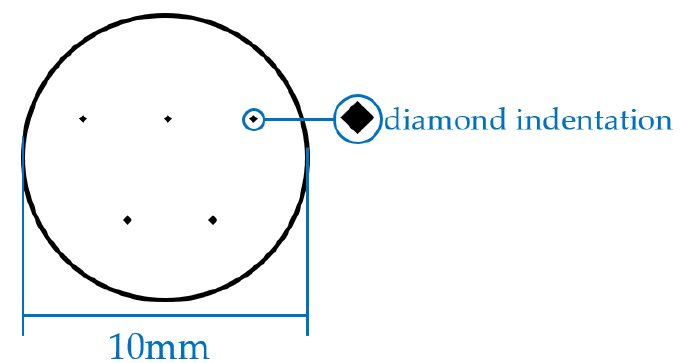
Figure 1. Schematic diagram of the distribution of test points.